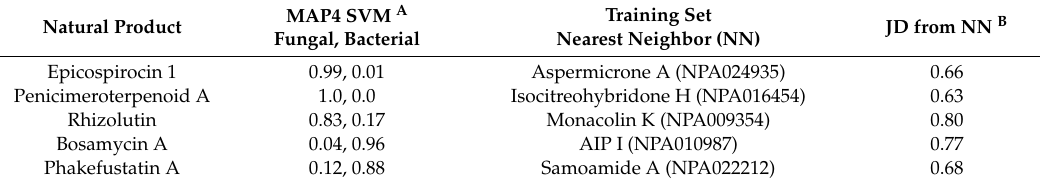
Table 4. MAP4 SVM classification of new microbial natural products and of Phakefustatin A. Natural